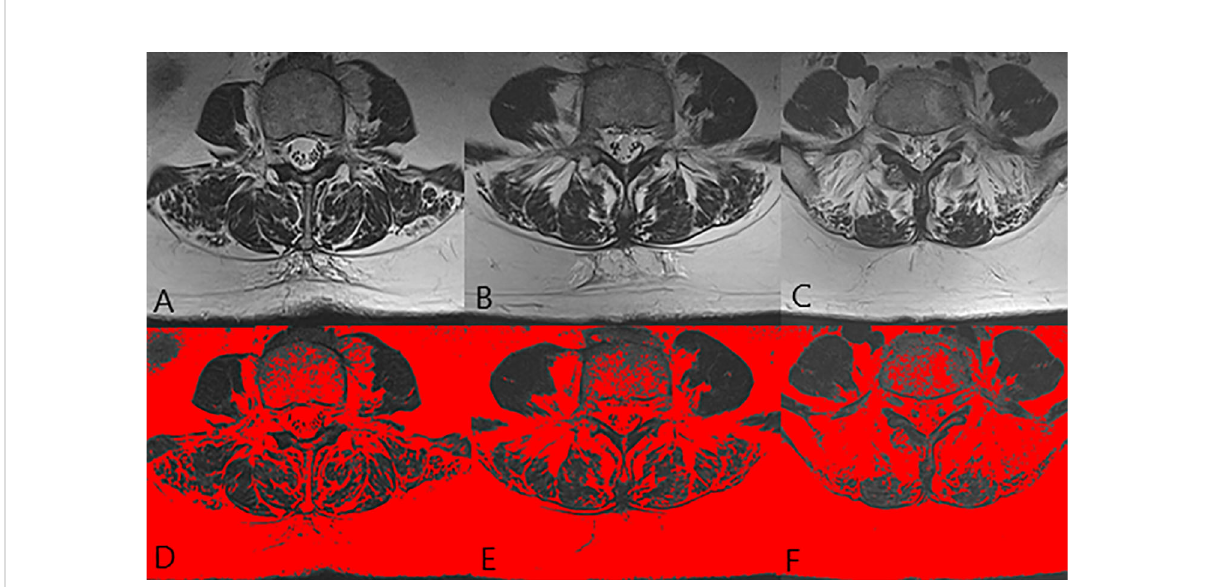
FIGURE 1 The images of paraspinal muscle in a 71 years old normal female. (A, D) were at L3 level. (B, E) were at L4 level. (C, F) were at L5 level. The FI of MF was 36.8% and the FI of ES was 48.2%.